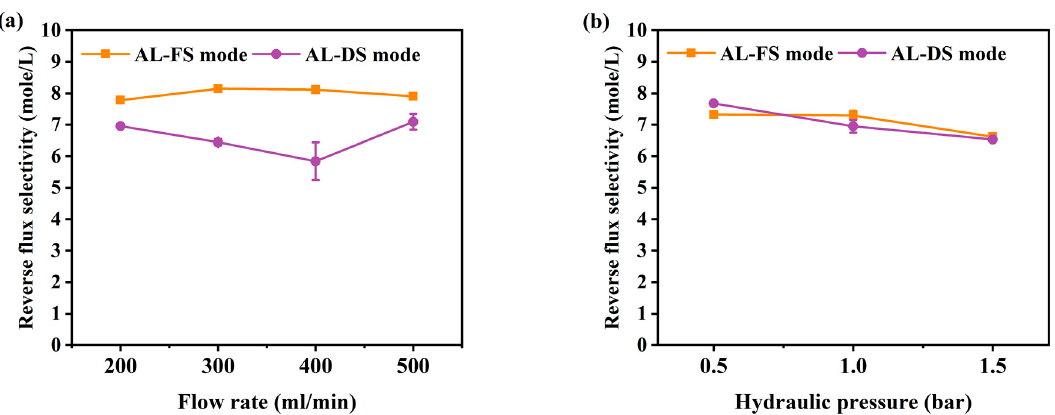
Figure 5. Comparison of the reverse flux selectivity under AL-FS and AL-DS mode. Calculated using the formula of J w / J s . ( a ) FO process (flow rate: 200–500 mL / min); ( b ) PAFO process (0.5–1.5 bar), and experimental flow rate condition is fixed 500 mL / min; Pressure was applied on the feed side.